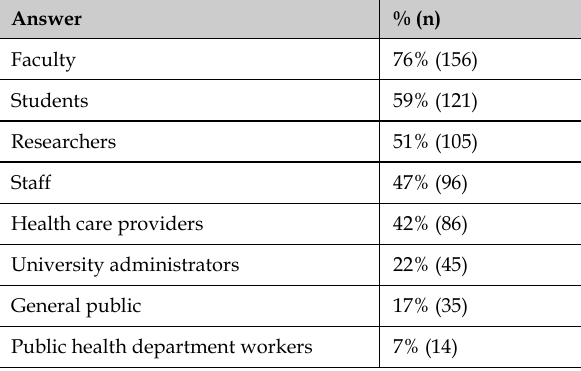
Table 3 Reference services and patron groups